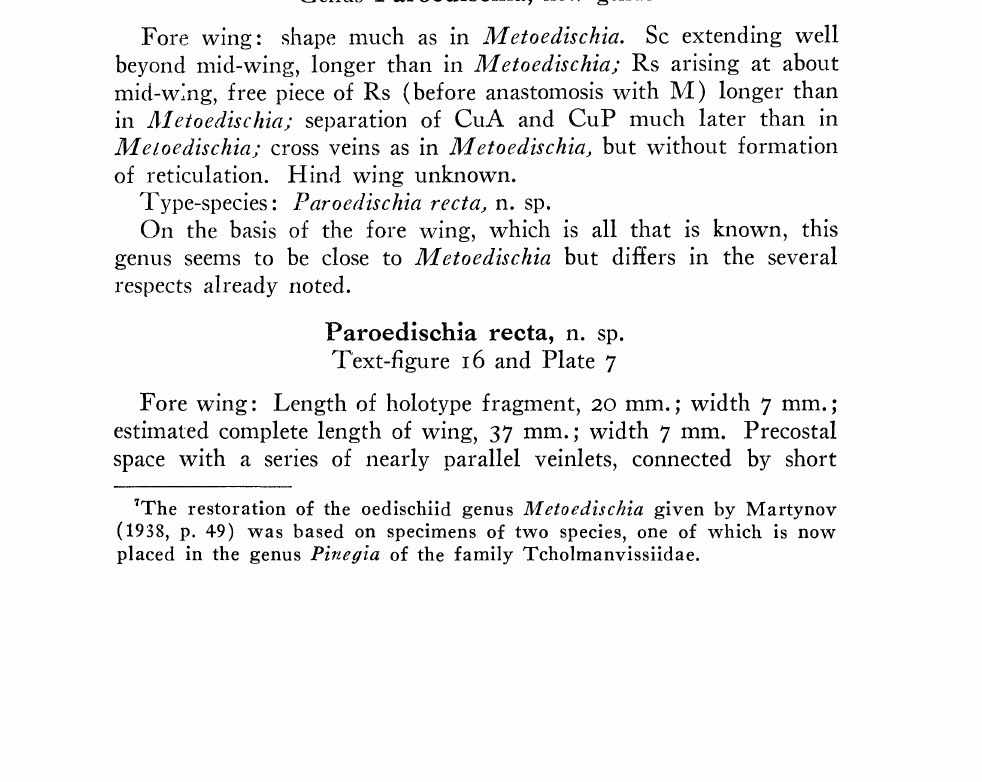
Text-figure 16. Paroedischia recta, n. sp. Drawing based on the holo- type (middle part of-wing), paratype No. 15638 (base of wing) and para- type no. 15757 (apex of